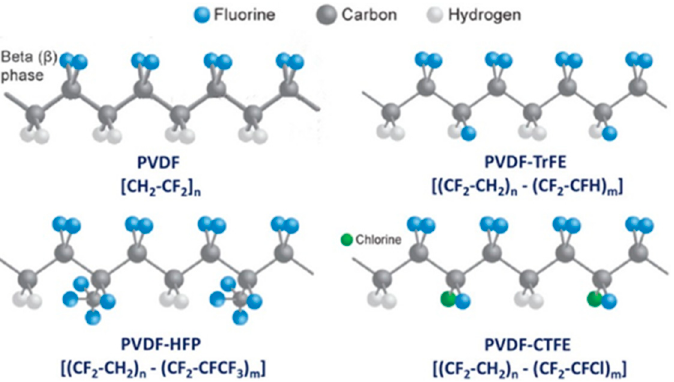
Figure 10. Structural configuration of PVDF and its copolymers: P(VDF–TrFE), P(VDF–HFP), and P(VDF–CTFE) (reprinted from [55]).